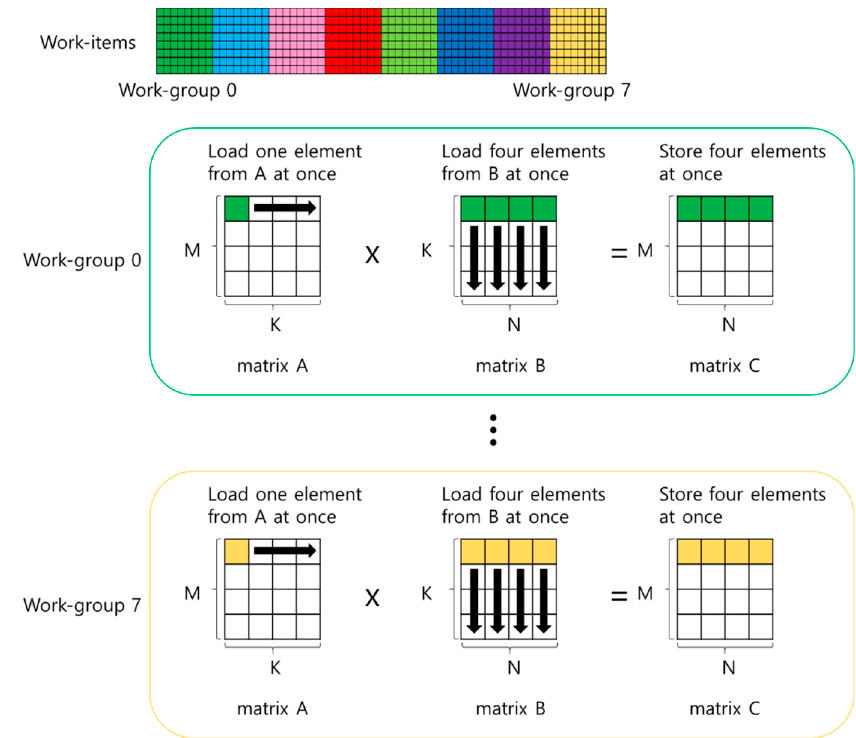
Figure 5. Parallel processing example of GEMM_NN using OpenCL.